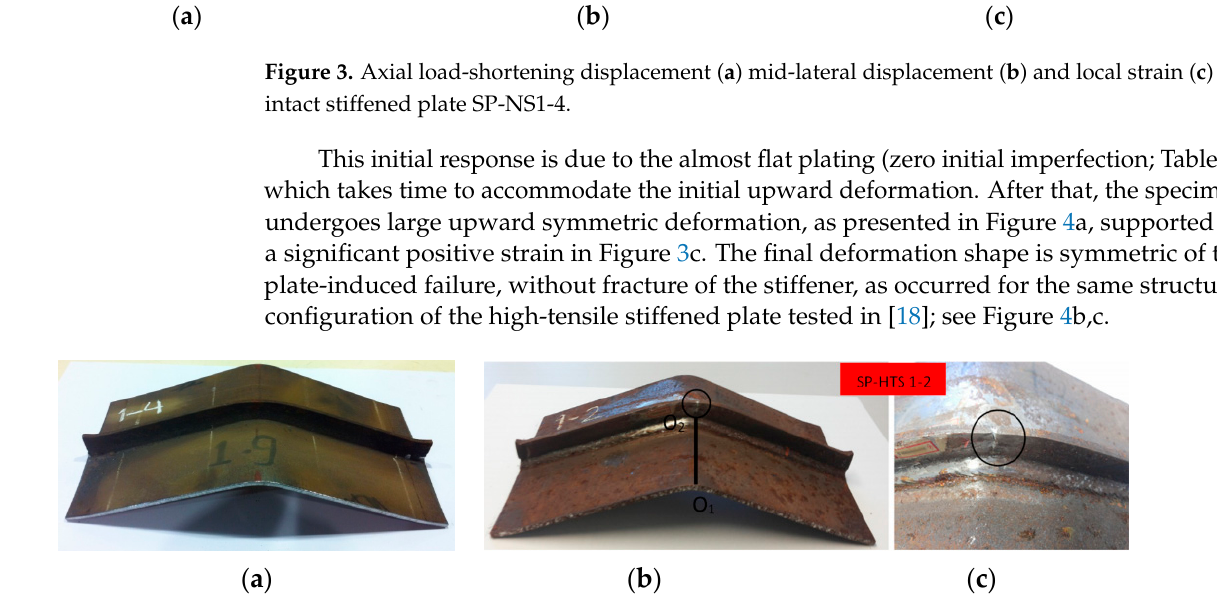
Figure 4. Post-collapse deformed shape for intact stiffened plate SP-NS1-4 ( a ) and SP-HTS1-2 ( b ) and ( c ).